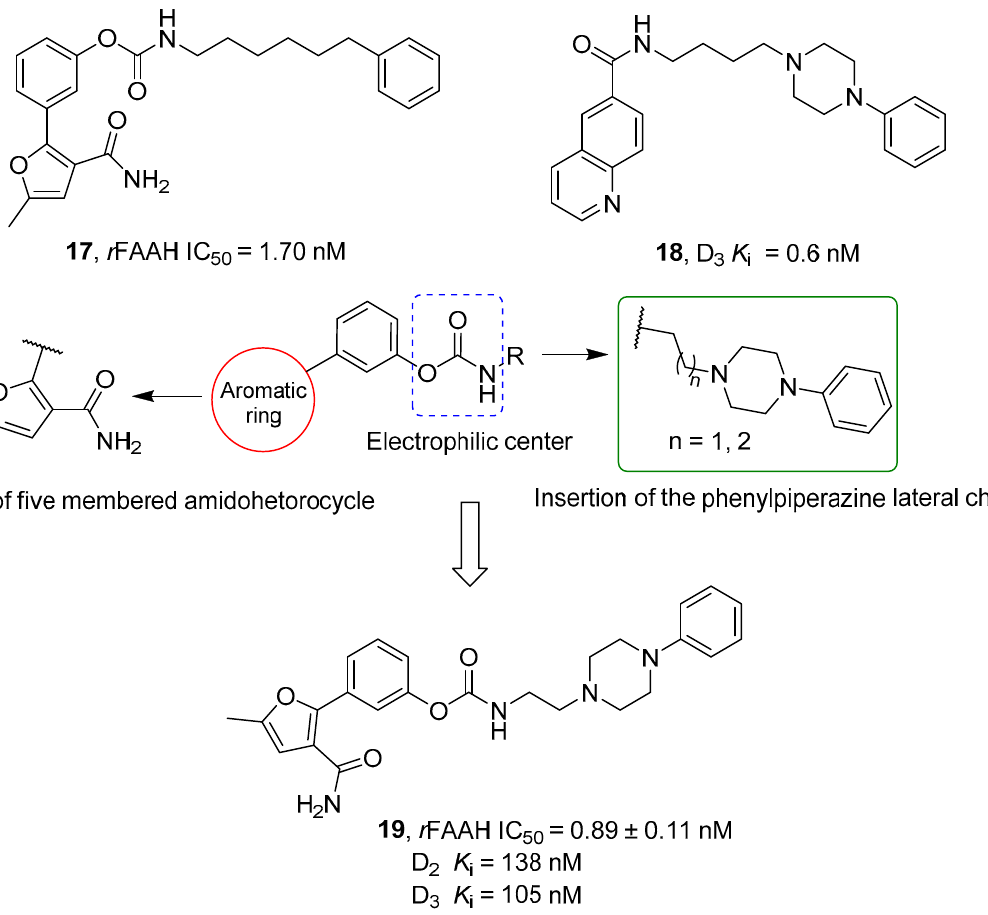
Figure 5. Representation of rational development of hybrid FAAH/dopamine receptor ligands 19, starting from FAAH inhibitor 17 and the multitarget compound 18